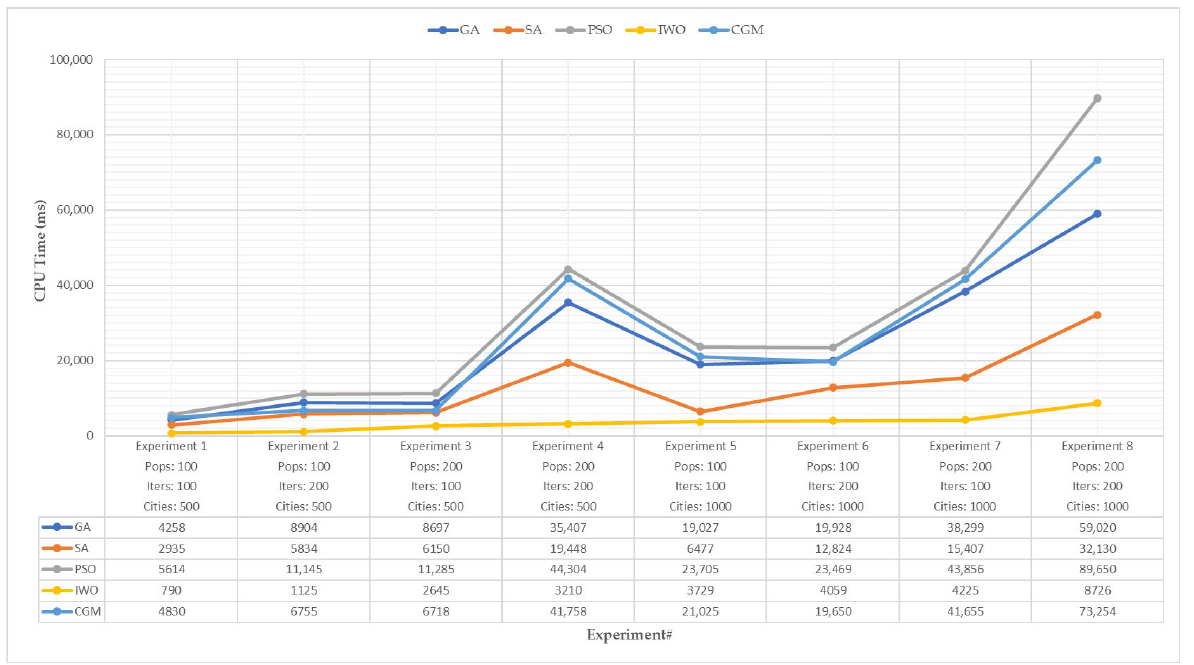
Figure 19. Evaluation results of execution time (CPU time) criterion for the optimal-placement-of- resources problem with large parameters (in milliseconds)